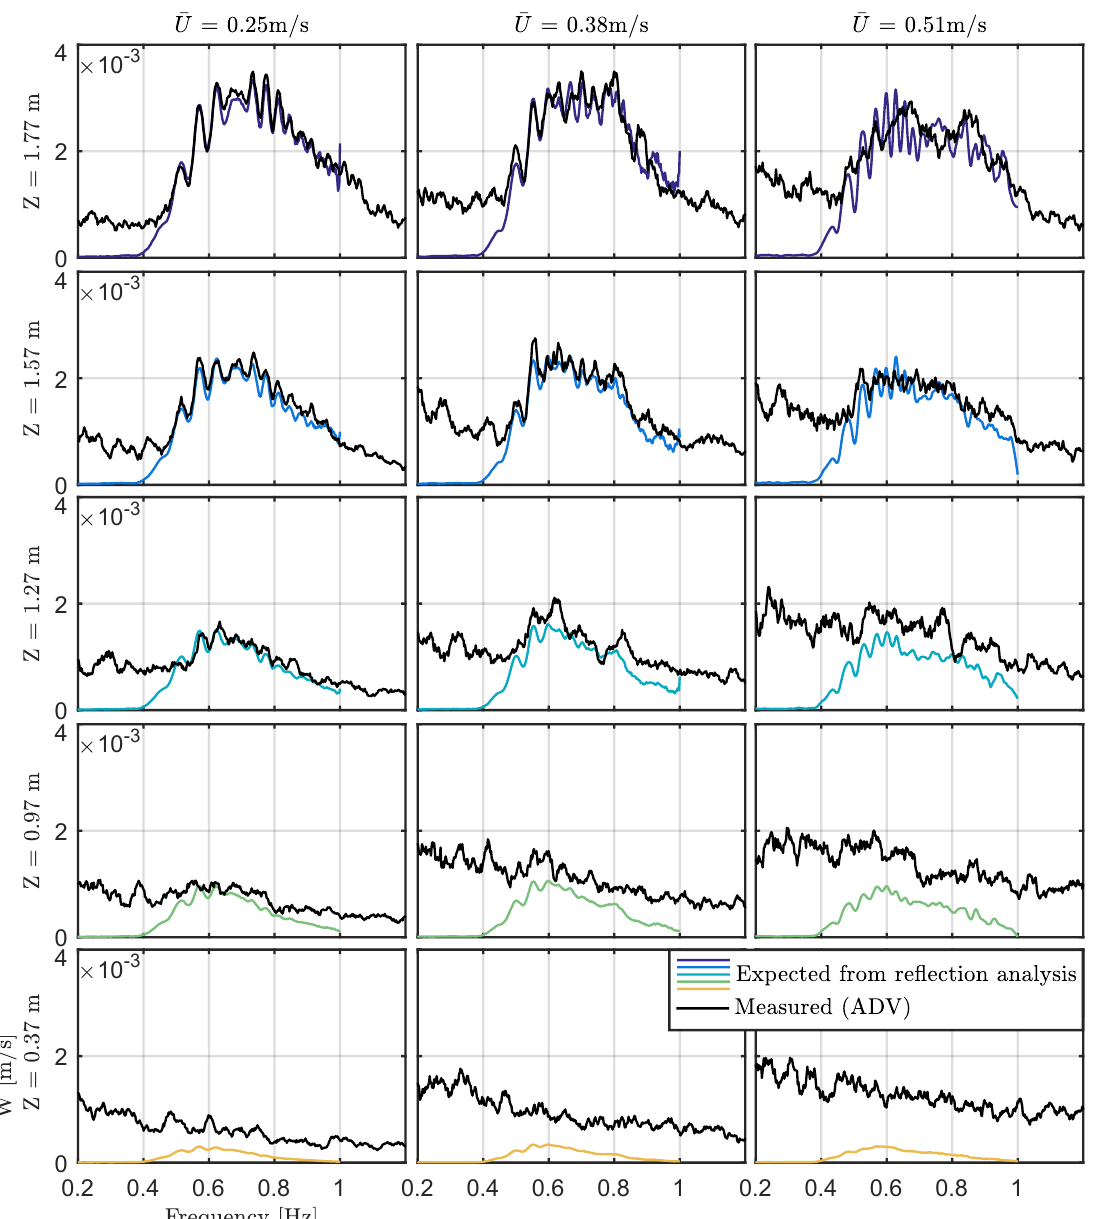
Figure 17. Measured vertical velocity spectra compared with those expected from theory. Shown for irregular wave cases (Sea States 5–7, Table 3) for each of the five ADV